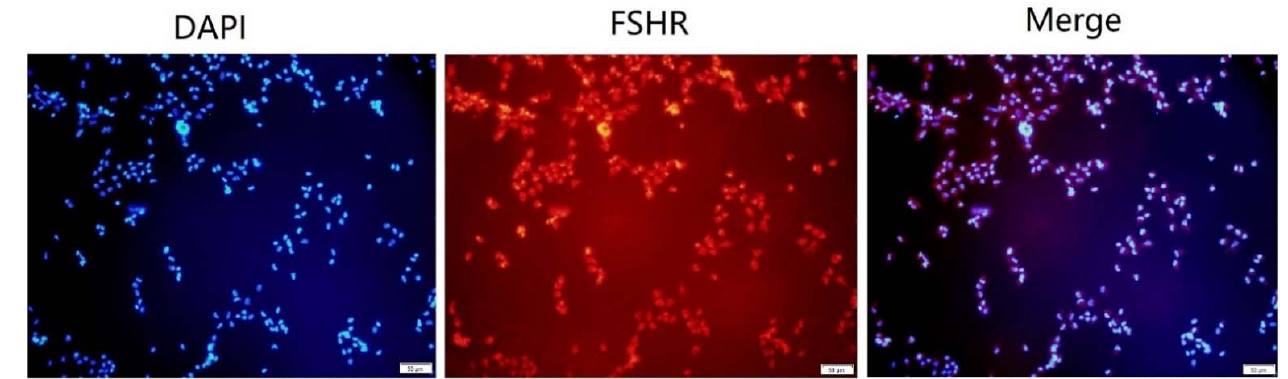
Figure 4. Granulosa cells were identified by immunofluorescence. Granular cell slide was given an immunofluorescent label with FSHR (red, a maker for the granulosa cells). Scale bar is 50 μ m.